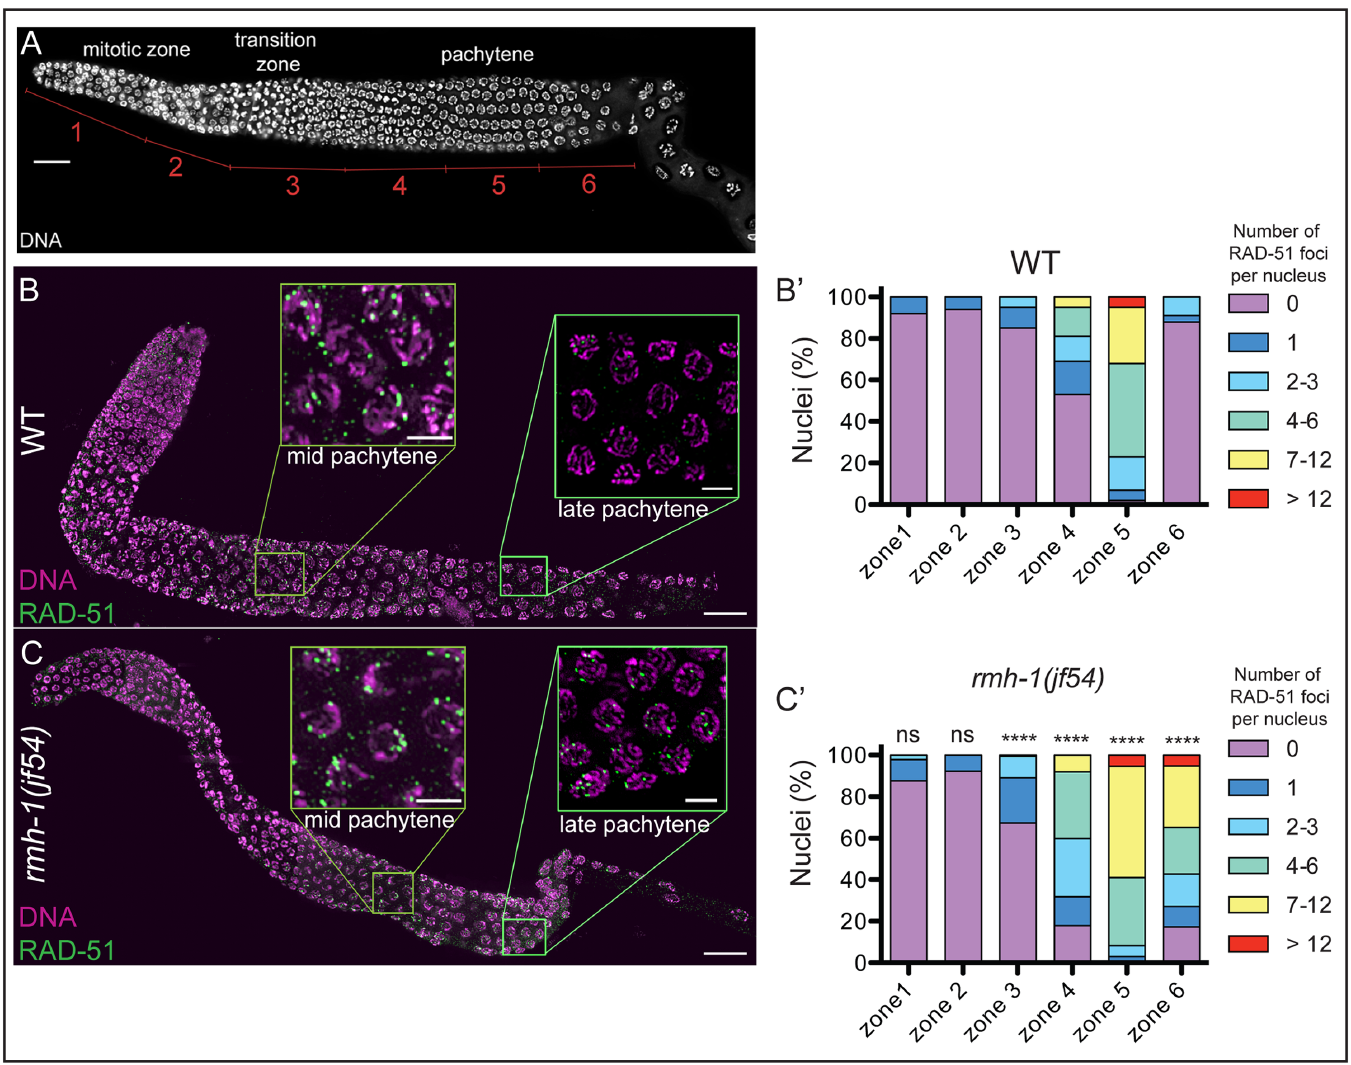
Fig 2. DNA double strand break repair is delayed in rmh-1 mutant. (B – C) Immunostaining for DNA strand exchange protein RAD-51, with insets for mid pachytene (MP) and late pachytene (LP) nuclei. (B) Almost no RAD-51 foci are detected in LP nuclei in wild-type (WT). (C) Abundant RAD-51 foci are still detected in LP nuclei in the rmh-1(jf54) mutant, but disappear in diplotene. (B 0 ,C 0 ) Quantification of the numbers of RAD-51 foci per nucleus. For quantification, gonads were divided into six equal zones (A). In both WT and rmh-1(jf54) , zones 1 and 2 correspond to the mitotic zone; zone 3 to transition zone and early pachytene; zones 4 to 5 to pachytene. Analysis of n = 124 – 231 nuclei per zone for each genotype. Distribution of RAD-51 foci is significantly different between WT and mutant for the zones 3 to 6 (Mann Whitney test, **** p < 0.0001). Scale bar = 20 μ m for gonads and 5 μ m for